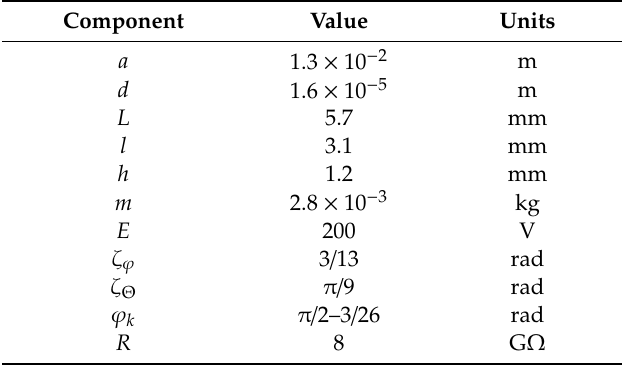
Figure 2. The sectional view of the resonator and the electrodes. Table 1. Parameters of the resonator and the electrostatic excitation and detection system.